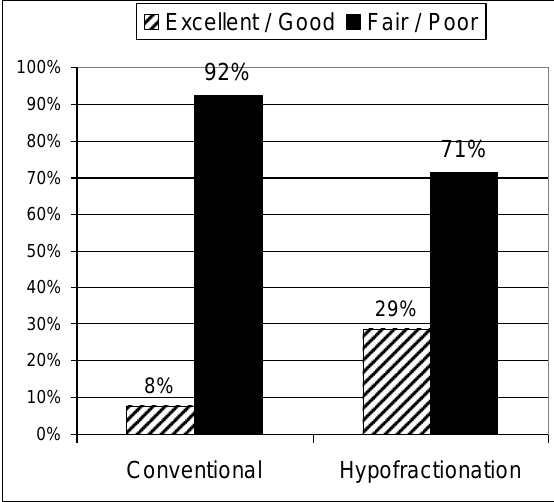
Figure 3: Physicians’ cosmetic rating two years after